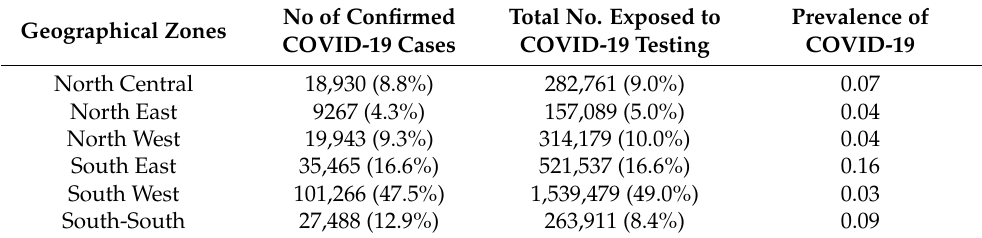
Table 3. Fatality Rate of COVID-19 during the Dry and Wet Seasons in Nigeria.